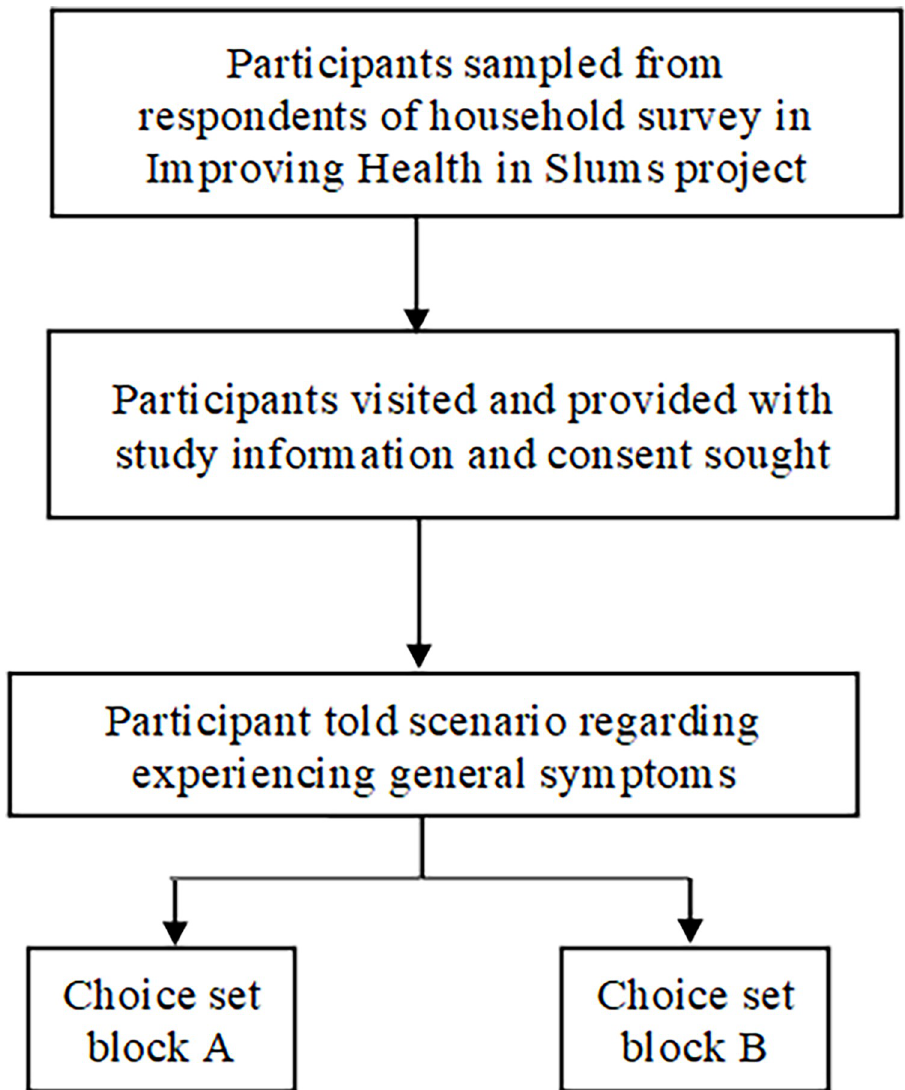
Fig 1. Flow diagram of